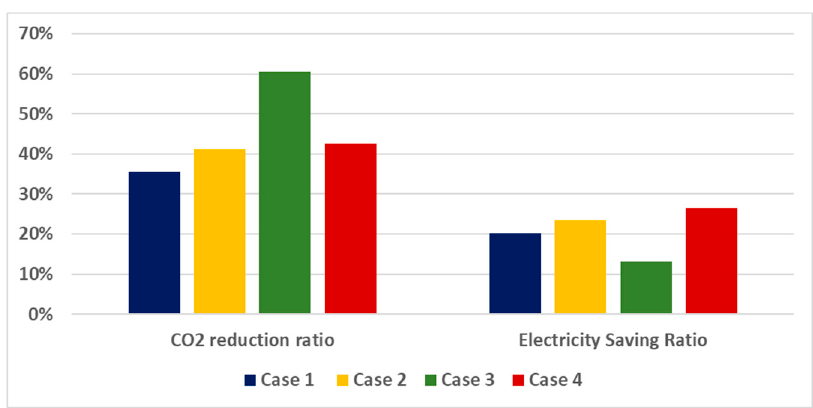
Figure 11. CO 2 reduction ratio and Electricity Saving Ratio Analysis.